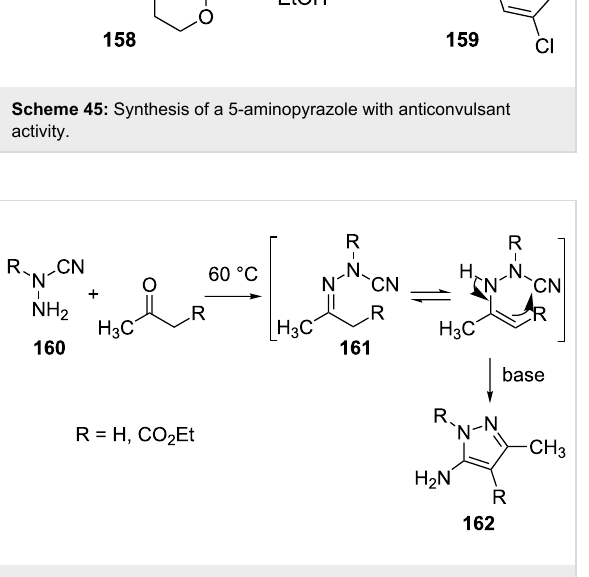
Scheme 46: Synthesis of tetrasubstituted 5-aminopyrazole derivatives.